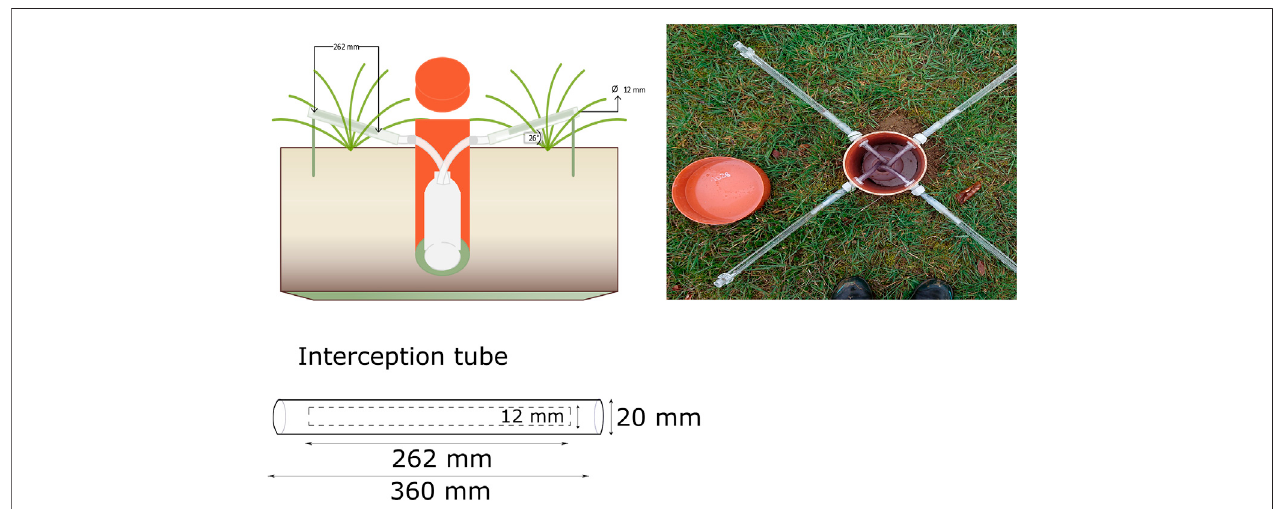
FIGURE 1 | Design of the interception tubes with explicit pipe dimensions. (left) cross-section view of the interception tubes and (right) top view.